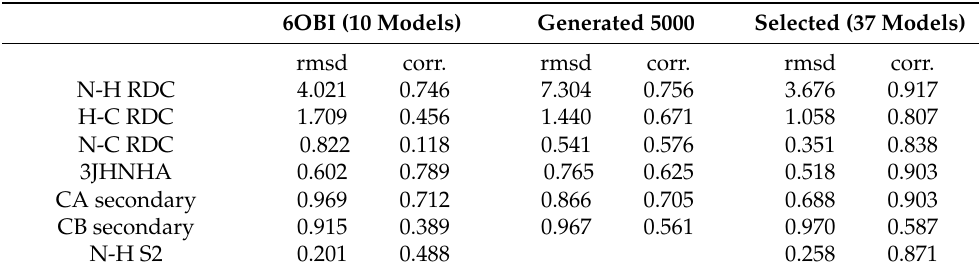
RMSD and correlation of selected back-calculated NMR parameters of MYO VI SAH